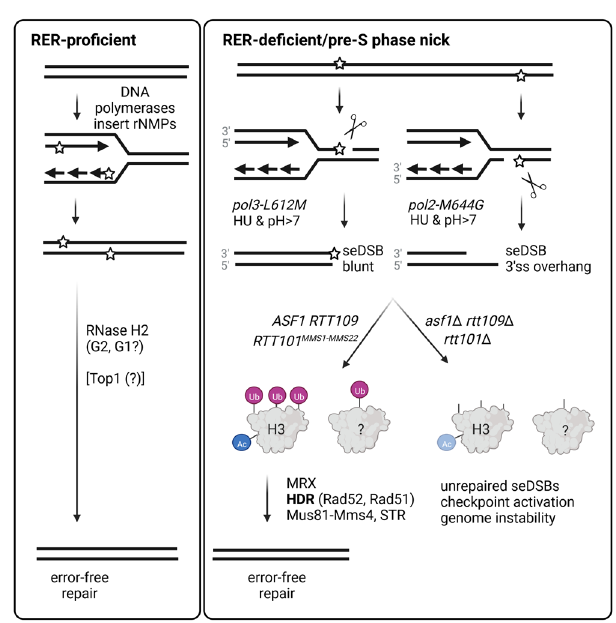
Fig. 5 | Top1-independent NLR pathway is essential when rNMPs cause pre-S phasenicksthatresultinseDSB. DNApolymerasestransientlyincorporatesingle rNMPs into the genome during replication and repair. The RER pathway removes genomicrNMPs immediatelyinthe subsequentG2phase.In RER-de fi cient, orRER- dysfunctional cells the Top1-mediated backup pathway deals with rNMP-removal. However, if high amounts of persistent genomic rNMPs accumulate in RER-de fi - cient, or RER-dysfunctional cells, the likelihood increases that hydrolysis-prone rNMPs form ssDNA nicks. When the replication fork encounters such an rNMP- derived nick, a toxic seDSB is formed. End topology of the seDSB may differ dependentonthelocationof thenick 39 .TorepairtherNMP-derivedseDSBlesions, functionalRCNAisrequired.ThehistoneremodelersAsf1and Rtt109actupstream of Rtt101 Mms1-Mms22 , presumablyaccompanied bythe resectionof the seDSBby MRX (Mre11-Rad50-Xrs2), followed by HDR (Rad52, Rad51) and resolution of the HDR intermediates (Mus81-Mms4, Sgs1-Top3-Rmi1) to result in the error-free repair of the seDSB. In RTT101 -de fi cient cells with high rNMP load, histone H3 does not become ubiquitylated and downstream error-free HDR repair of the seDSB is compromised causing genomic instability likely by alternative, error-prone repair attempts. Abbreviations: NLR rNMP-derived nick lesion repair, rNMP single ribo- nuclesoide monophates, RER ribonucleotide excision repair, seDSB single-ended double strand break, ssDNA single stranded DNA, RCNA replication-coupled nucleosome assembly, HDR homology-directed repair. Created with